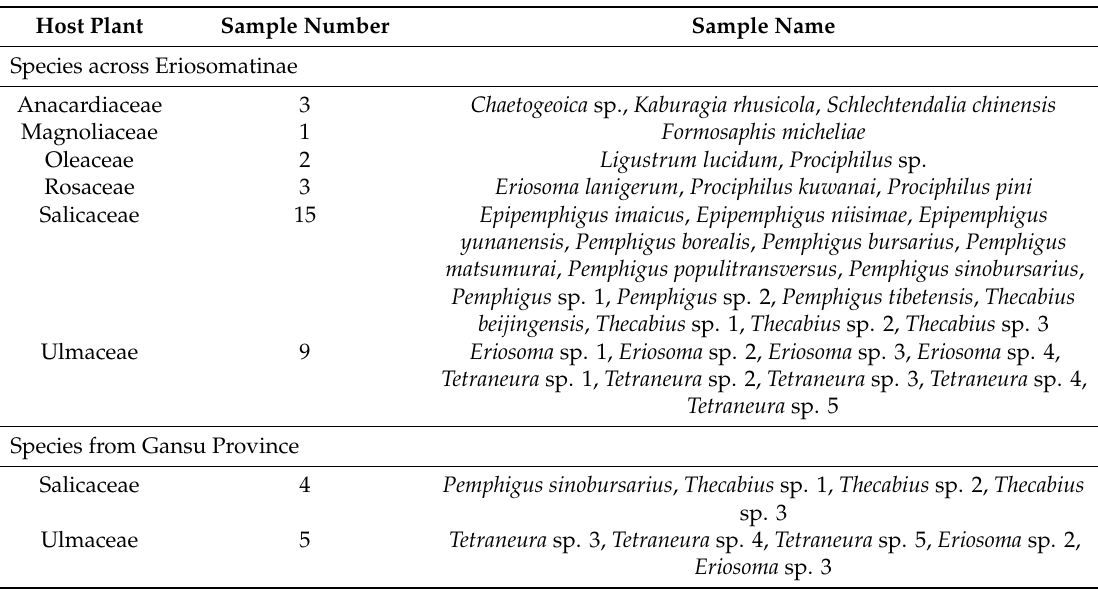
Table 1. Grouping information for host plant of Eriosomatinae